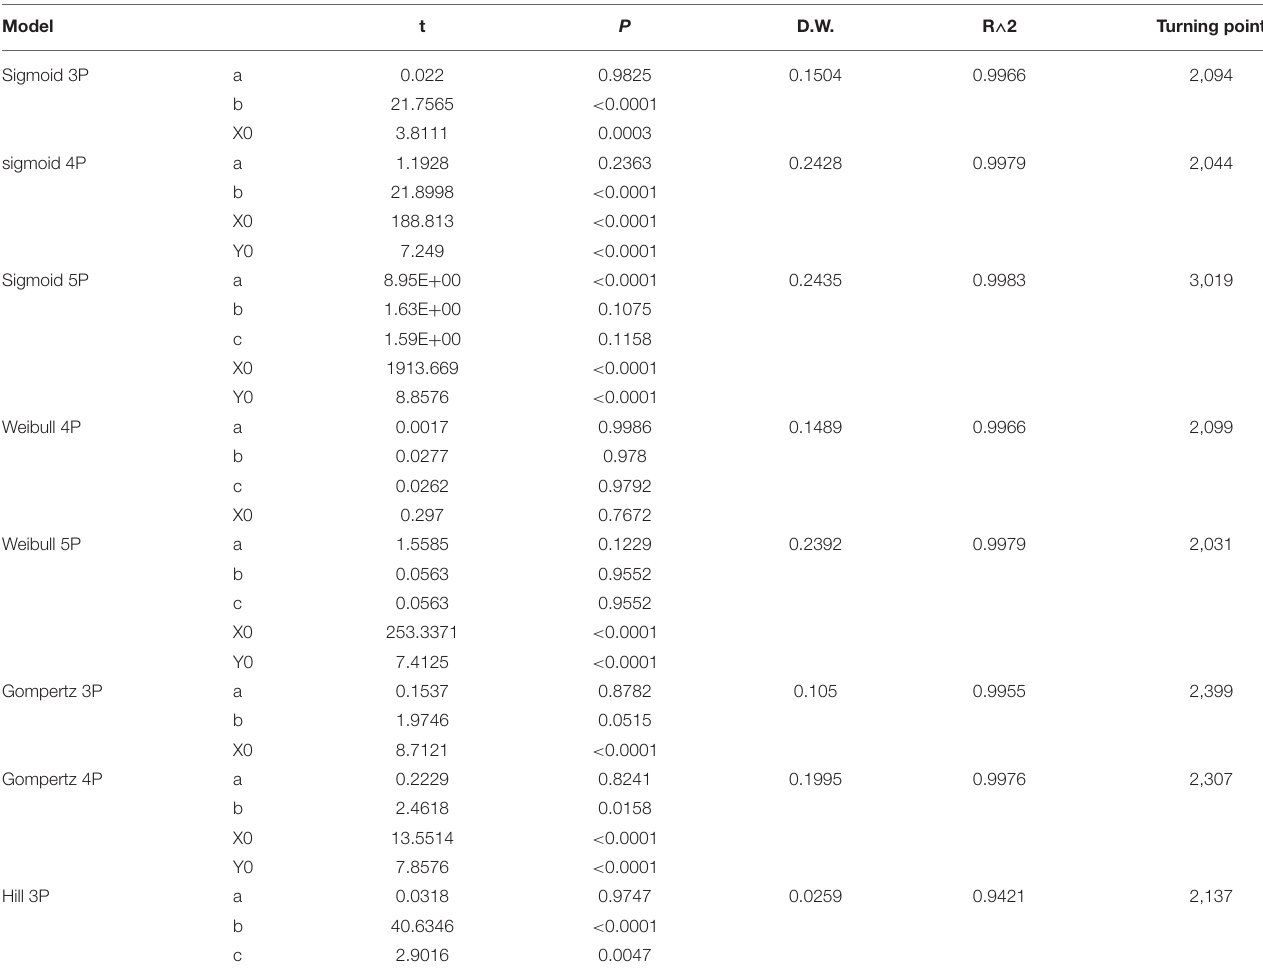
TABLE 2 | Non-linear regression models for patents in cereal screening. Model t P D.W. R ∧ 2 Turning